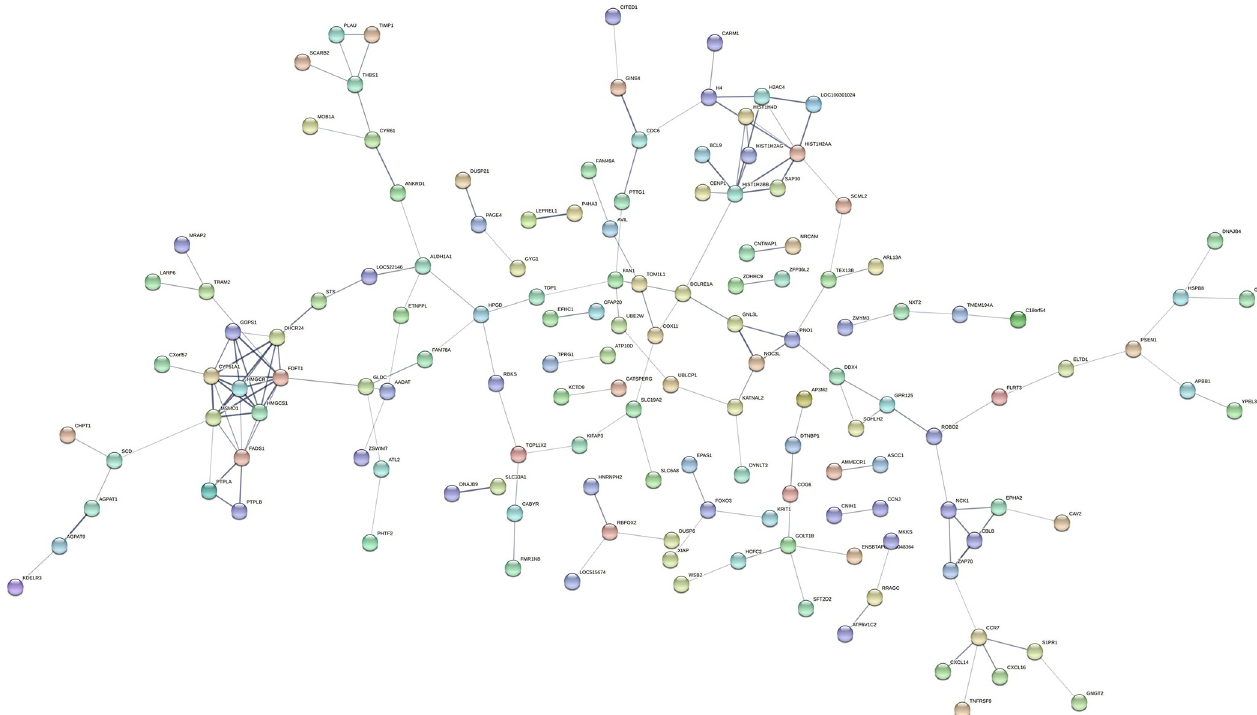
Fig 9. Possible protein–protein connections of non-overlapping differentially expressed genes. STRING analysis of non-overlapping genes expressed differentially in blastocysts from synchronously vs. directly cleaved embryos. Only genes with nodes in the network association are presented. For better view of the figure, it is highly recommended to use the magnifier